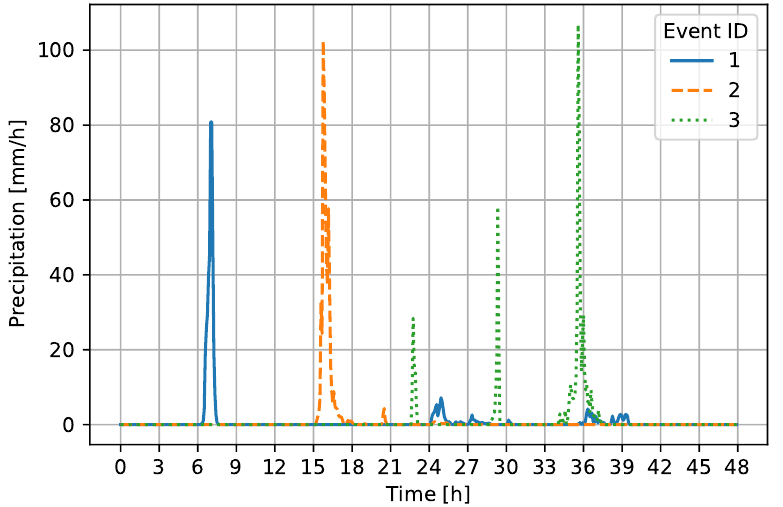
Figure 7. Precipitation time series for historic flood events in Hooglanderveen. All time series start one day prior to the reported flooding, as there can be a delay in reporting. This can be seen with precipitation events 1 and